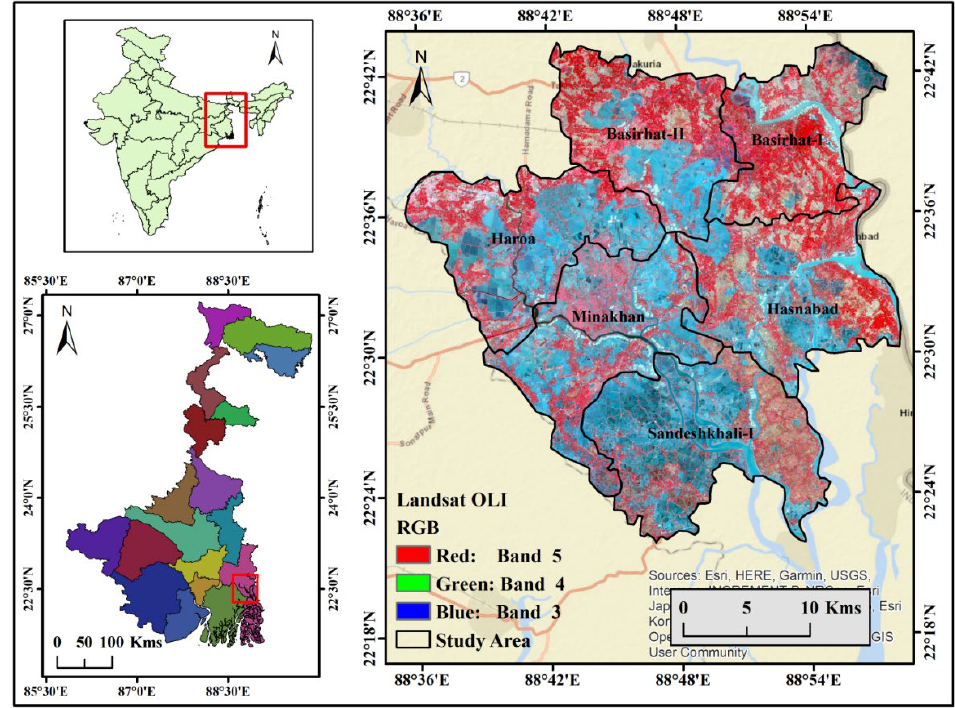
Figure 1. Location map of the selected study area. The red frame shows the identification of the study location.